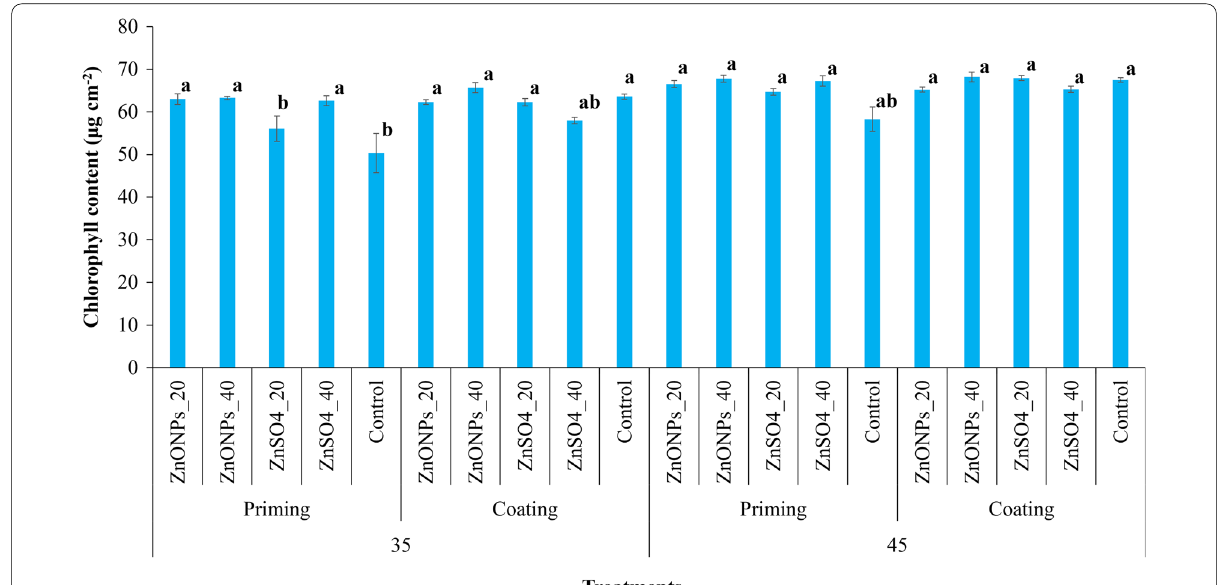
Fig. 2 Effect of application of Zn‑sources (Zn‑salt and ZnONPs) on chlorophyll content (µg cm − 2 ) of maize cv. PMH‑1 cultivated under field